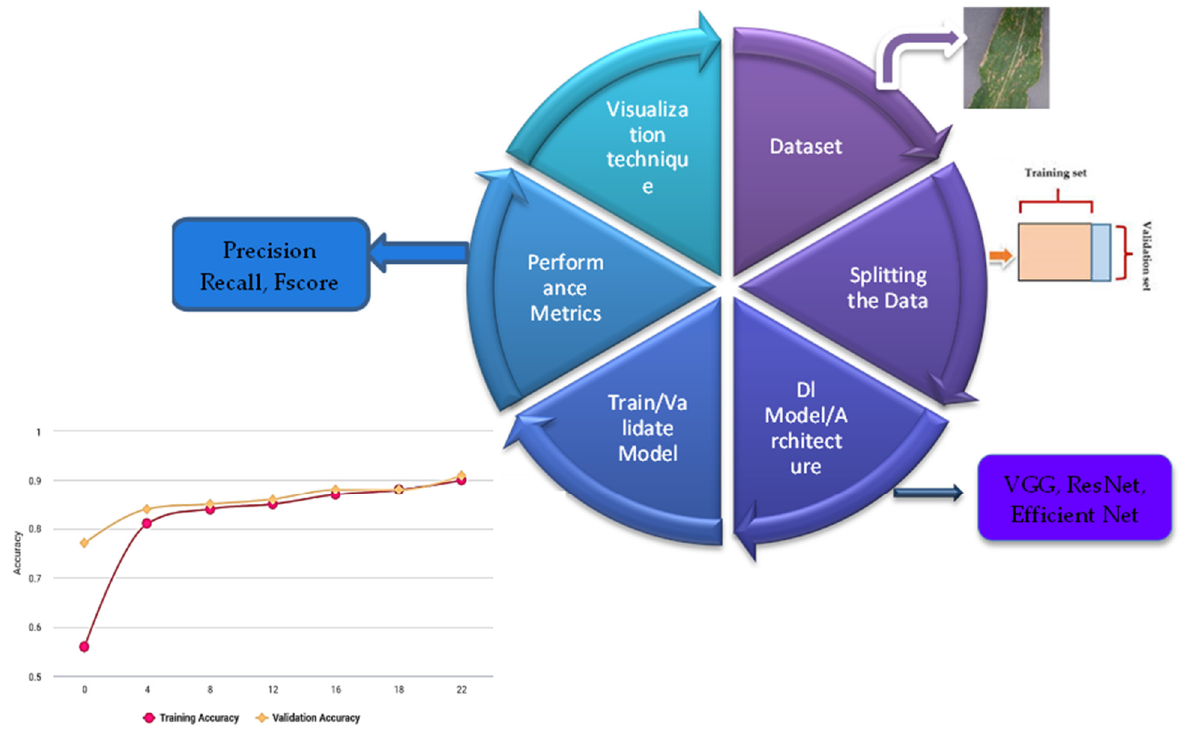
Figure 1. Overall conceptual view of prediction of leaf-based disease.